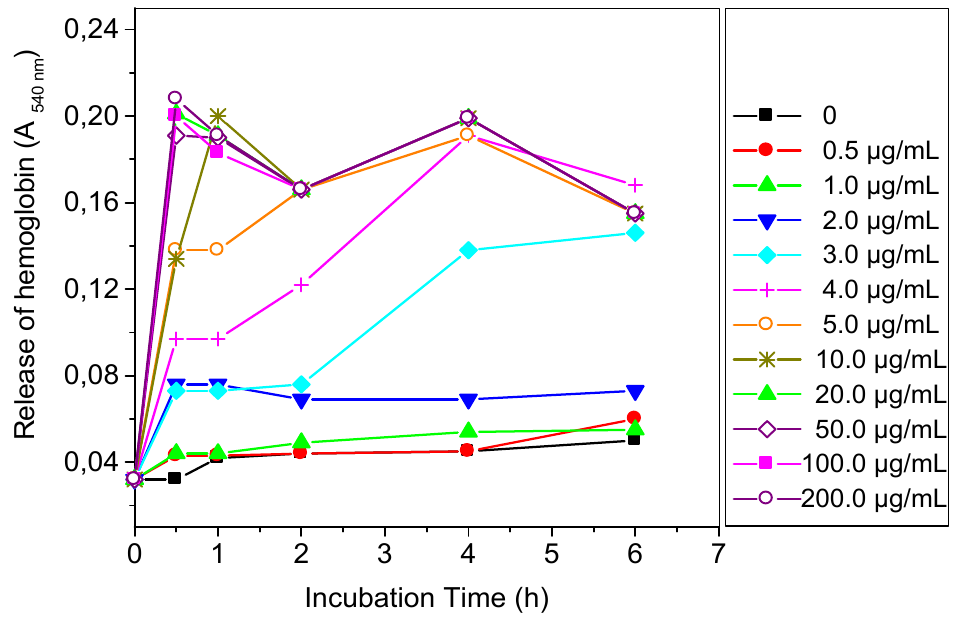
Figure 1. Hemolysis of erythrocytes induced by purified Thermus thermophilus rhamnolipids ( Tth RLs) at concentration ranged from 0 to 200 μ g/mL of Tth RLs, which